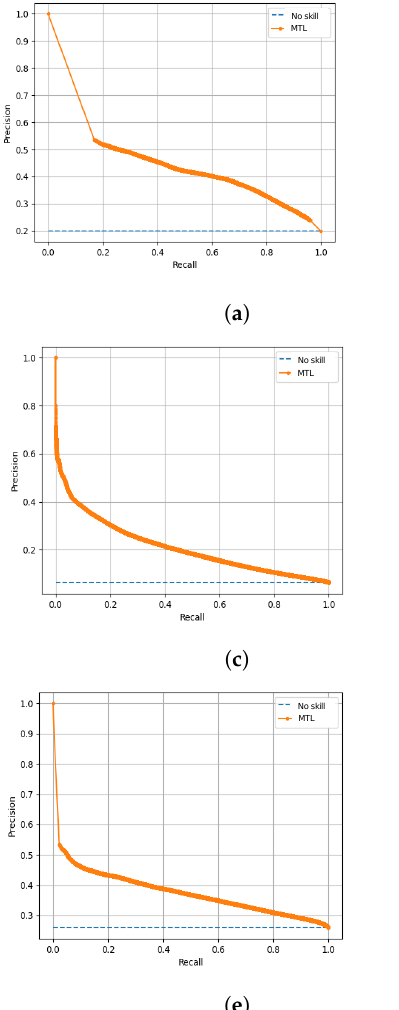
Figure 9. Precision vs recall curves: ( a ) for MIP; ( b ) for DC; ( c ) for MRL; ( d ) for regular; ( e ) for